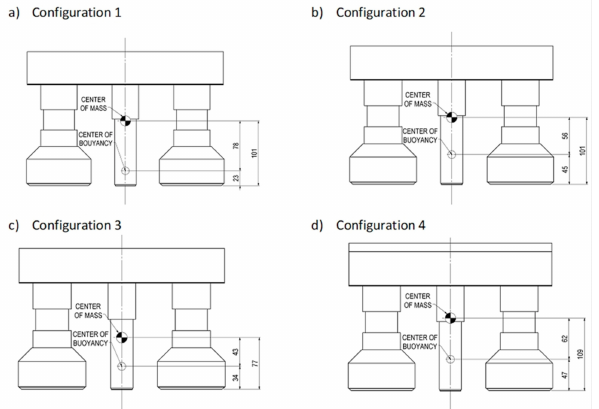
Figure 6. 2D schematic of each Configuration of the floating platform model showing the location of the center of mass and center of buoyancy measured from the line of reference at the bottom of the structure legs ( a ) Configuration 1 ( b ) Configuration 2 ( c ) Configuration 3 ( d ) Configuration